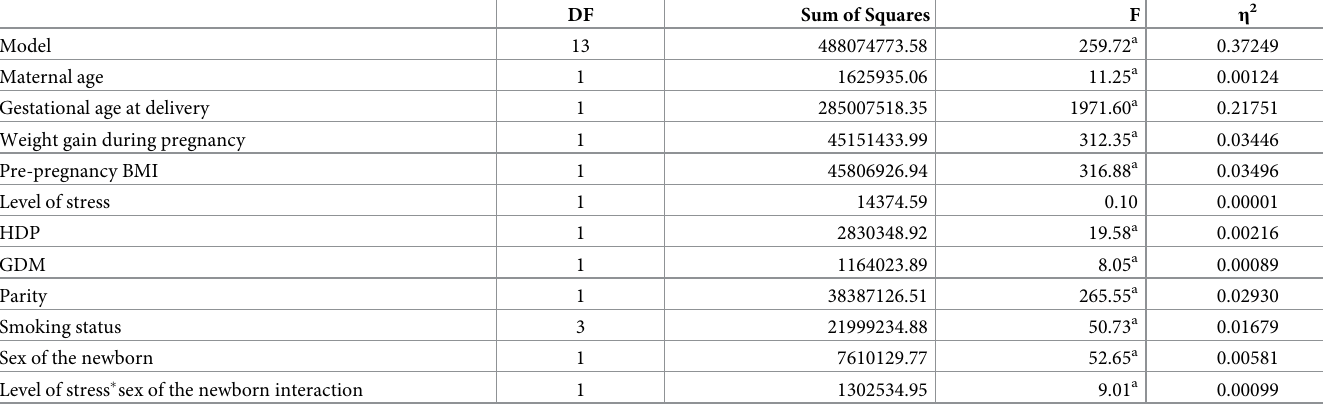
Table 3. Analysis of the covariance in the final